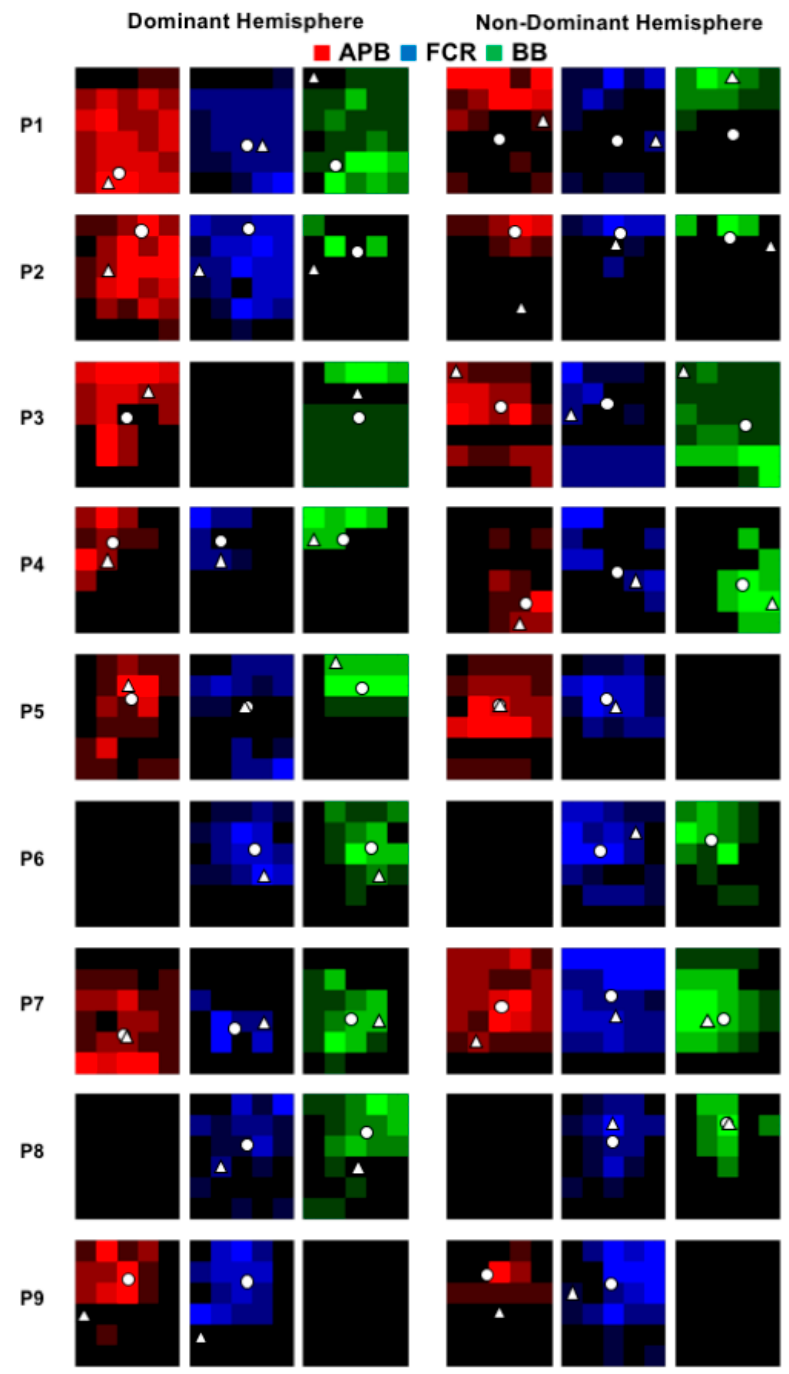
Figure 3. Individual cortical territory plots for each hemisphere and muscle for the SCI group. Pixel maps represent the size of the cortical territories and the white circle indicates the location of the CoG.